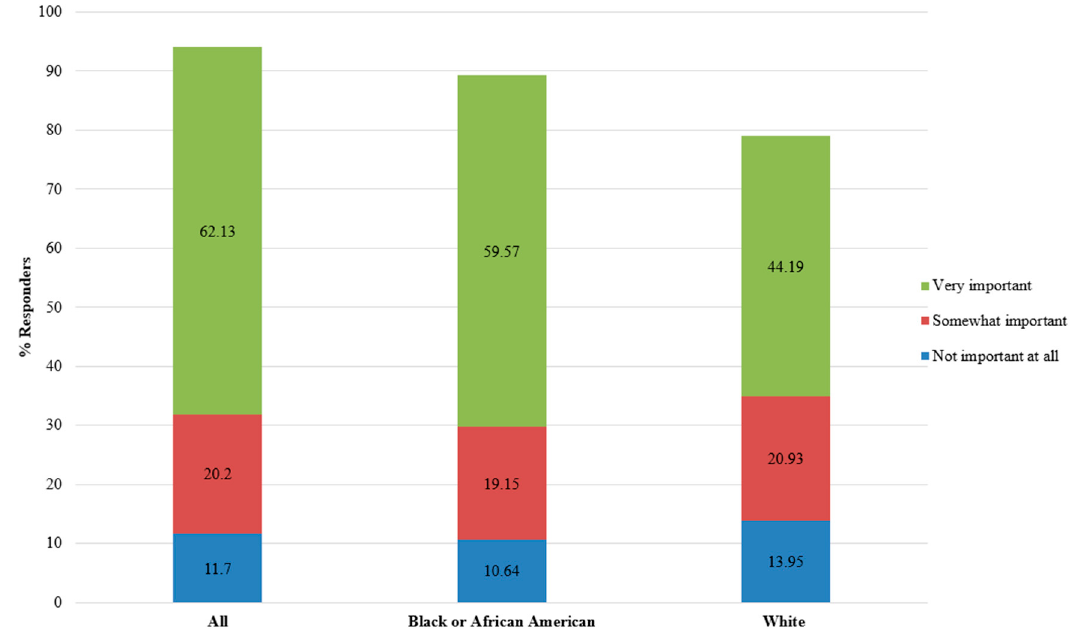
Figure 1. Survey question assessing the importance of return of genetic and health information. Survey participants ( n = 101) were asked, “If you participated in a study that collected your genetic and health information, how important is it to you that you receive results from the study? Circle the number that is closest to how you feel.” A 1–5 Likert-type scale was used, where 1 represented “Not important at all,” 5 represented “Very important,” and the remaining values represented varying degrees of “Somewhat important”. Two respondents circled two numbers instead of a single number on the scale, and these ranks were then averaged (resulting in ranks 3.5 and 4.5). Three responses (not important at all, somewhat important, and very important) were plotted using a stacked chart for all responders ( n = 94), Black or African American responders ( n = 47), and White responders ( n = 43; x -axis). The stacked chart is presented as % responders ( y -axis) color coded by rank starting with rank 1 (“Not important at all” in blue) and ending with rank 5 (“Very important” in green).